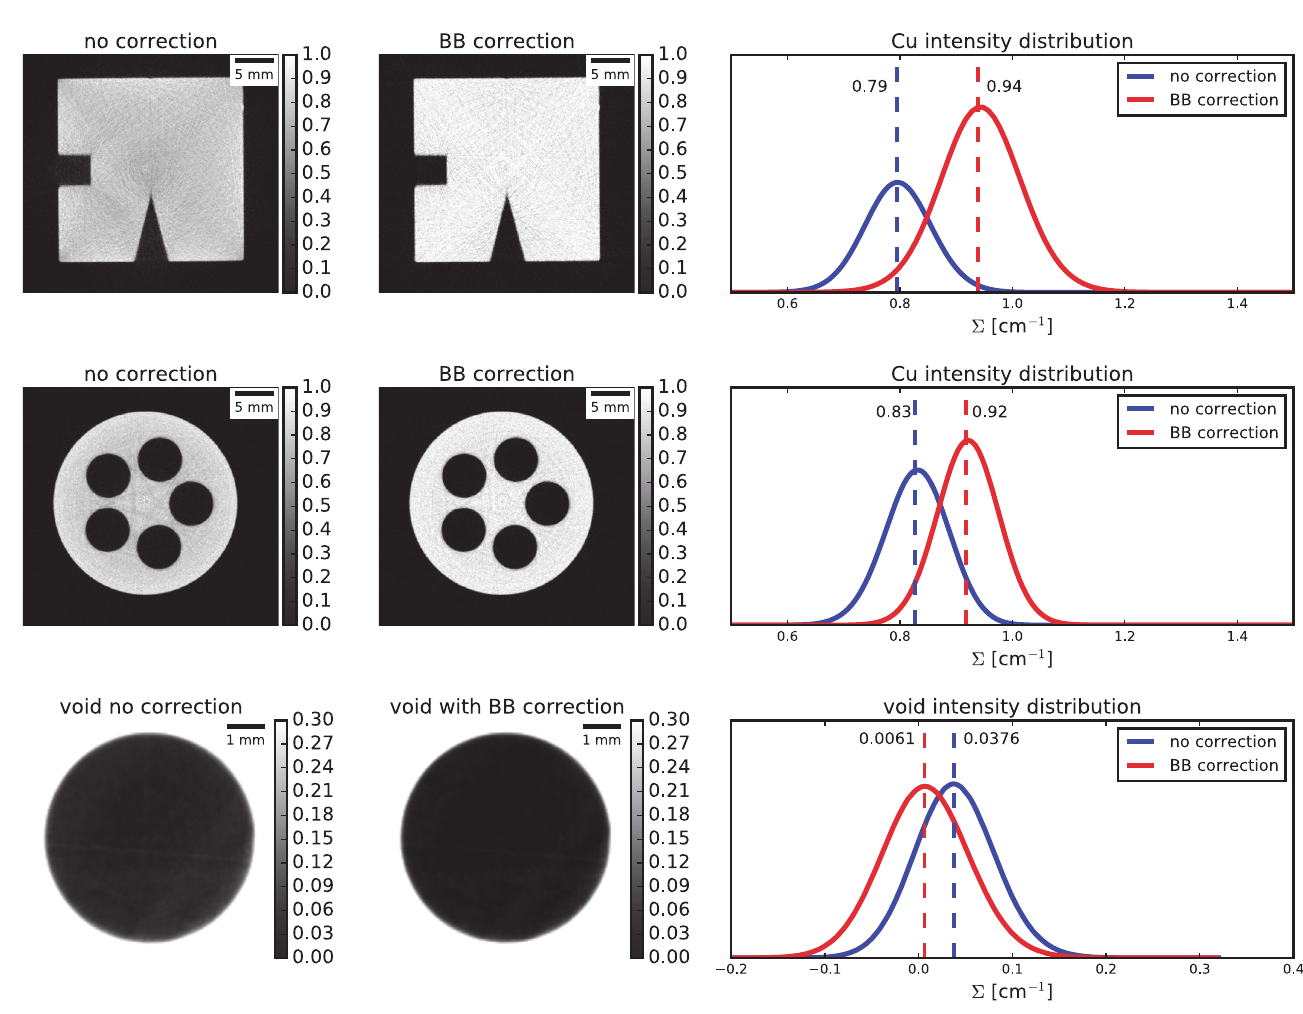
Fig 7. Results for the copper